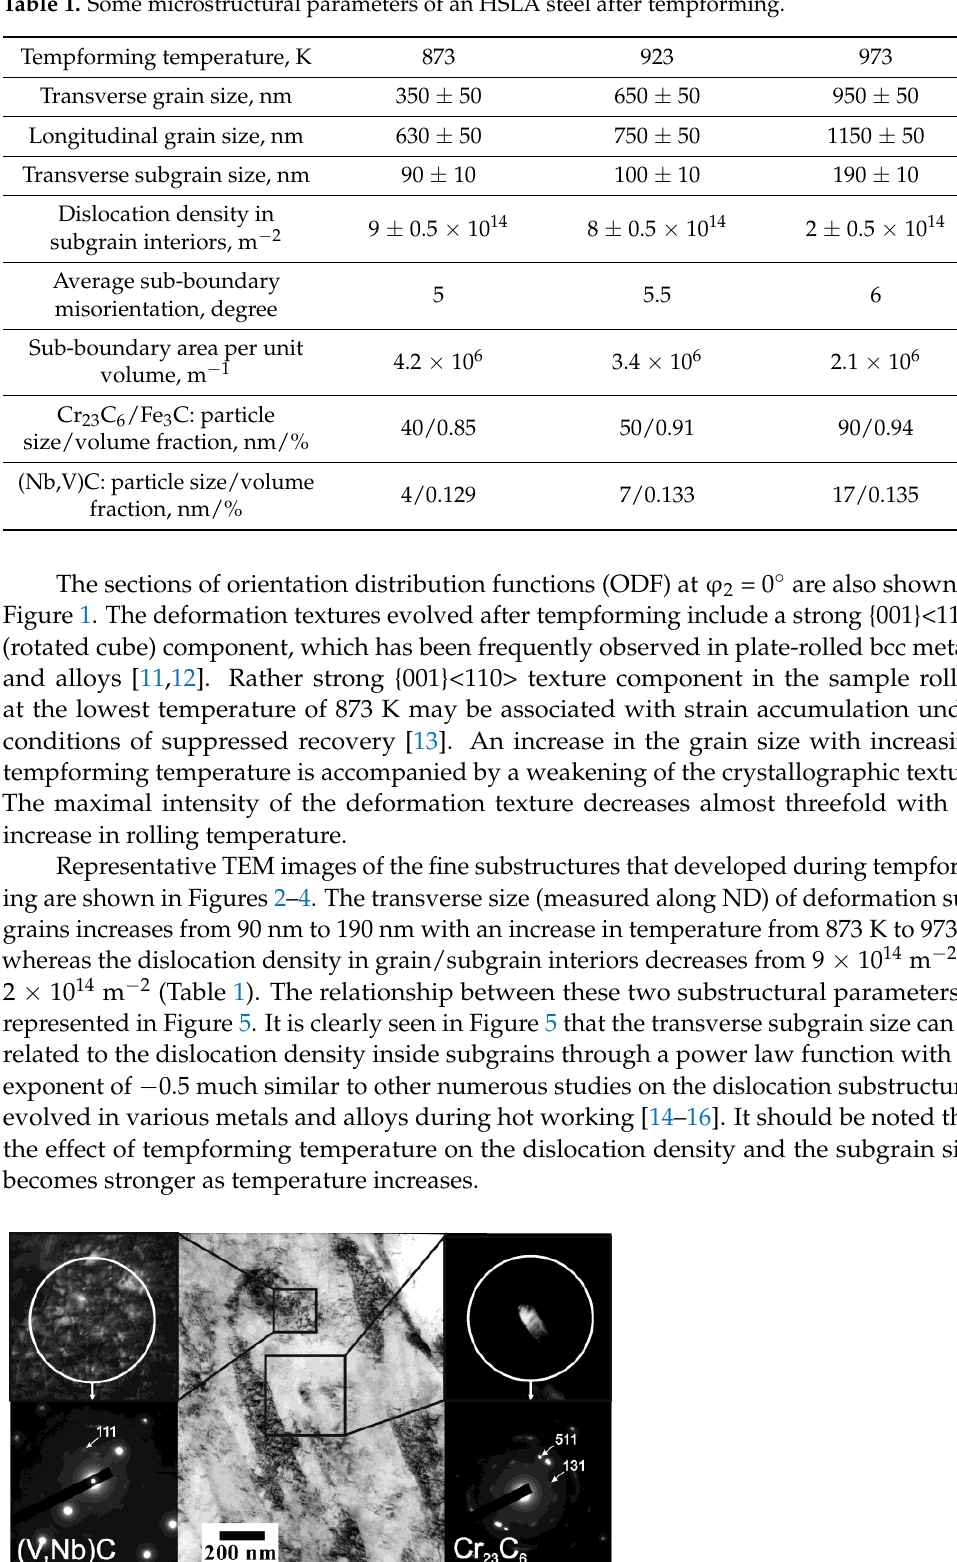
Table 1. Some microstructural parameters of an HSLA steel after tempforming.